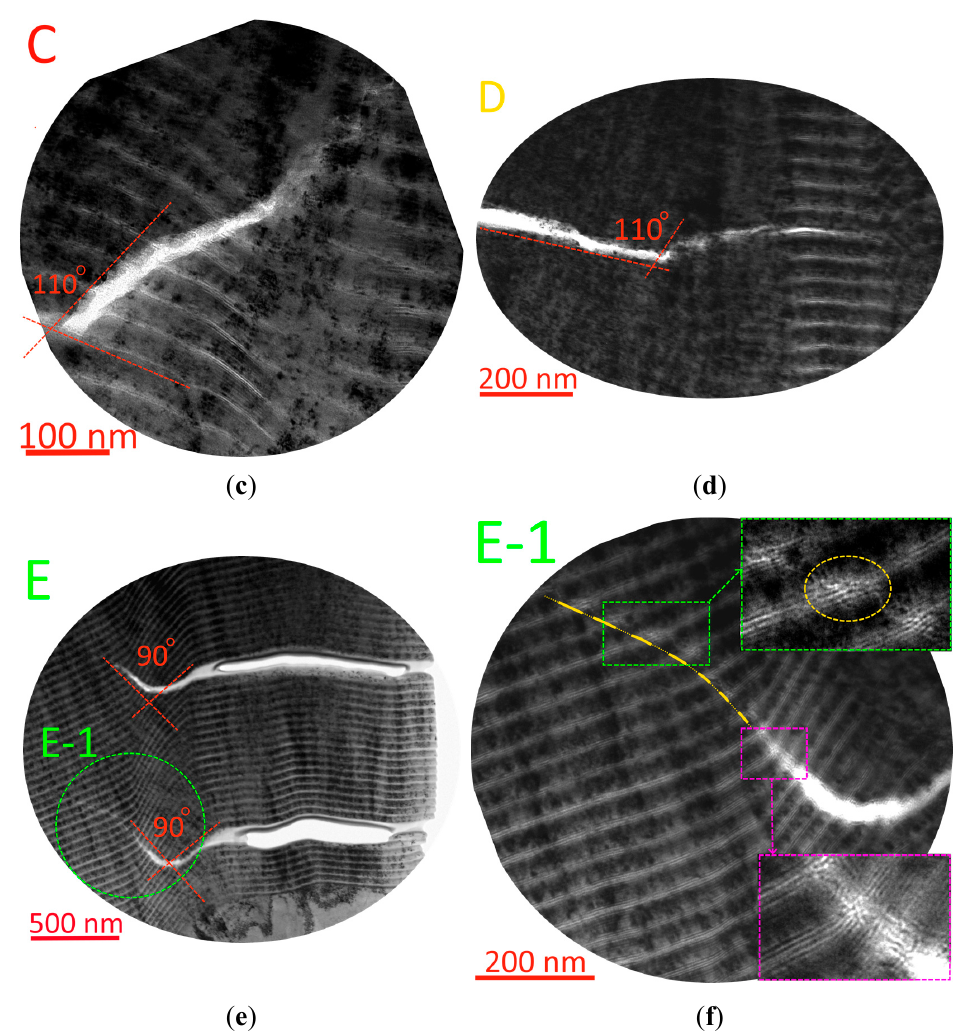
Figure 5. Investigation of the patterns of wear and fracture in Coating M1. ( a – e ) Investigation of the pattern of cracking and the specific features of the relationship between the direction of propagation of delamination and cracks cutting through the nanolayers; ( f ) mechanism of cracking in the nanolayer structure. The localization of areas A,B,C,D and E is shown in Figure 4. The above assumptions were partially confirmed by the results of the SAED analysis (Figure 6d,e).